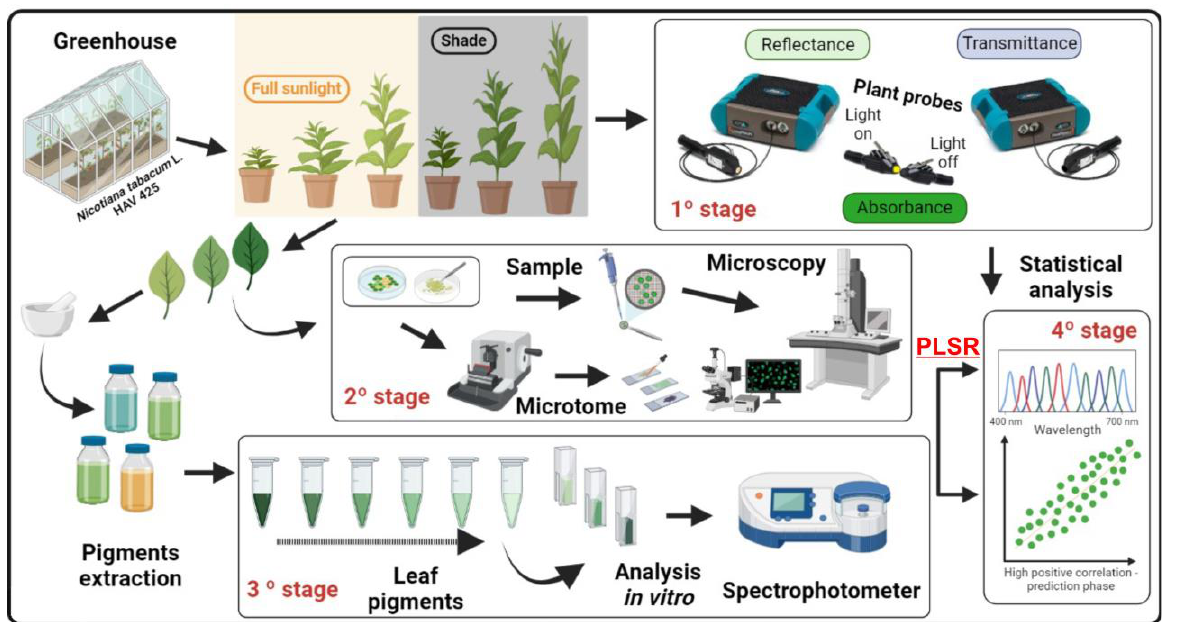
Figure 1. Flowchart describing the prediction of chlorophylls and carotenoids in Nicotiana tabacum L., using one or two hyperspectral sensors. Plants are grown in a greenhouse under full sunlight or shading ( 1 ◦ stage ), and their leaves are measured using single or two hyperspectral sensors. ( 2 ◦ stage ), the leaves are analyzed using light and transmission electron microscopy. ( 3 ◦ stage ), the pigments are quantified using classical destructive analysis with a spectrophotometer. ( 4 ◦ stage ), the data are analyzed using PLS statistics.